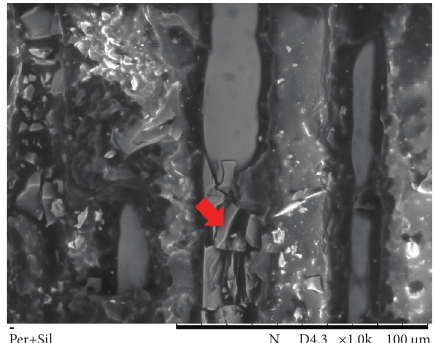
Per+Sil Figure 3: SEM image of a post surface from the peroxide and silanization group (1000x magnification). Areas with an irregular morphological aspect, indicating surface roughness, which facili- tated wetting by silane and the flow of resinous cement, are visible (arrow).